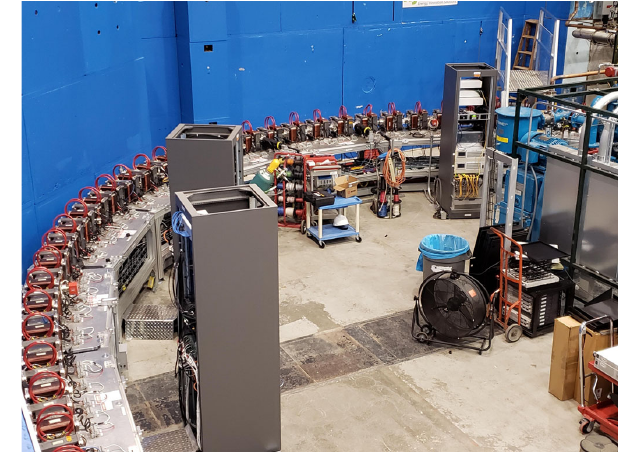
FIG. 3. Second arc of the installed CBETA return